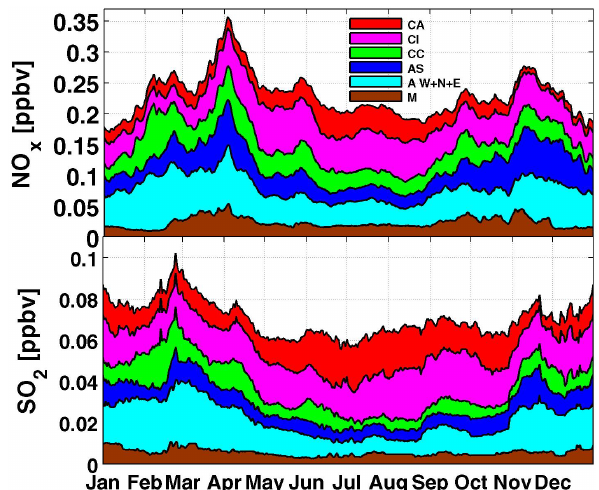
Fig. 8. Mean 1995–2008 annual cycles of NO x and SO 2 concentra- tions as a function of SYNALP weather